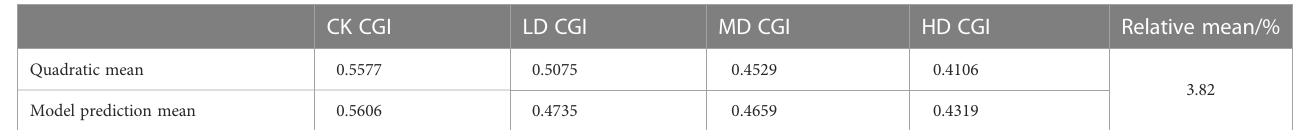
TABLE 5 Comparison of model prediction and quadratic mean CGI